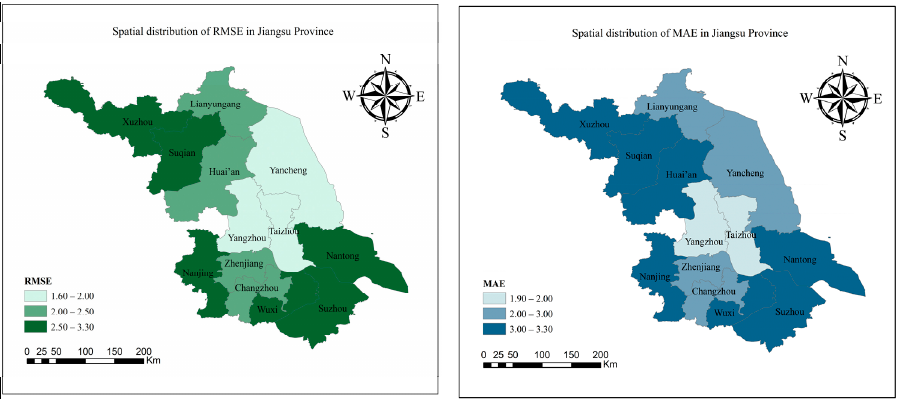
Figure 12. Spatial distribution of temperature prediction errors in Jiangsu Province.